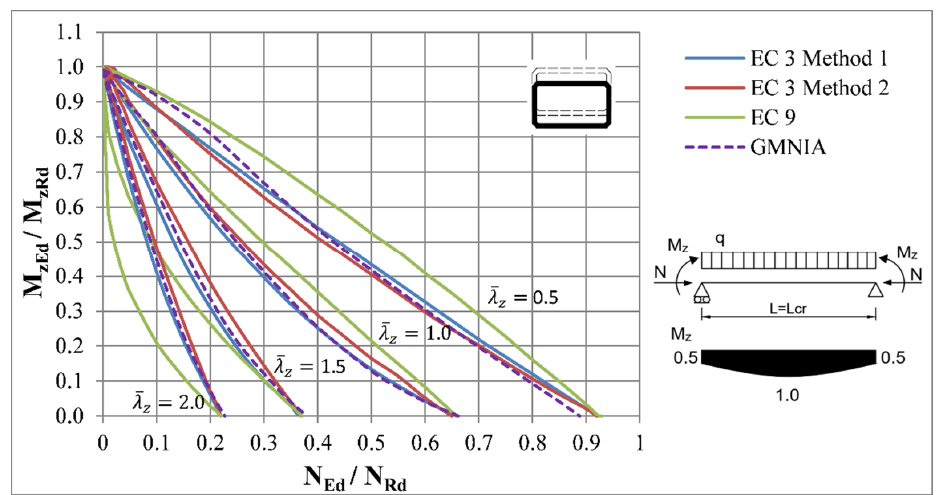
Figure 47. Interaction curves for weak axis flexural buckling of beam-columns with RHS cross-section.